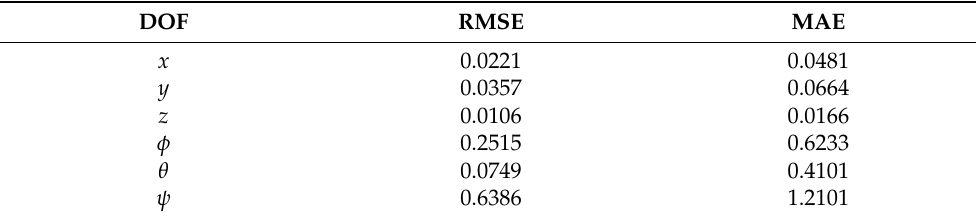
Table 3. RMSE and MAE metrics of object position/orientation.